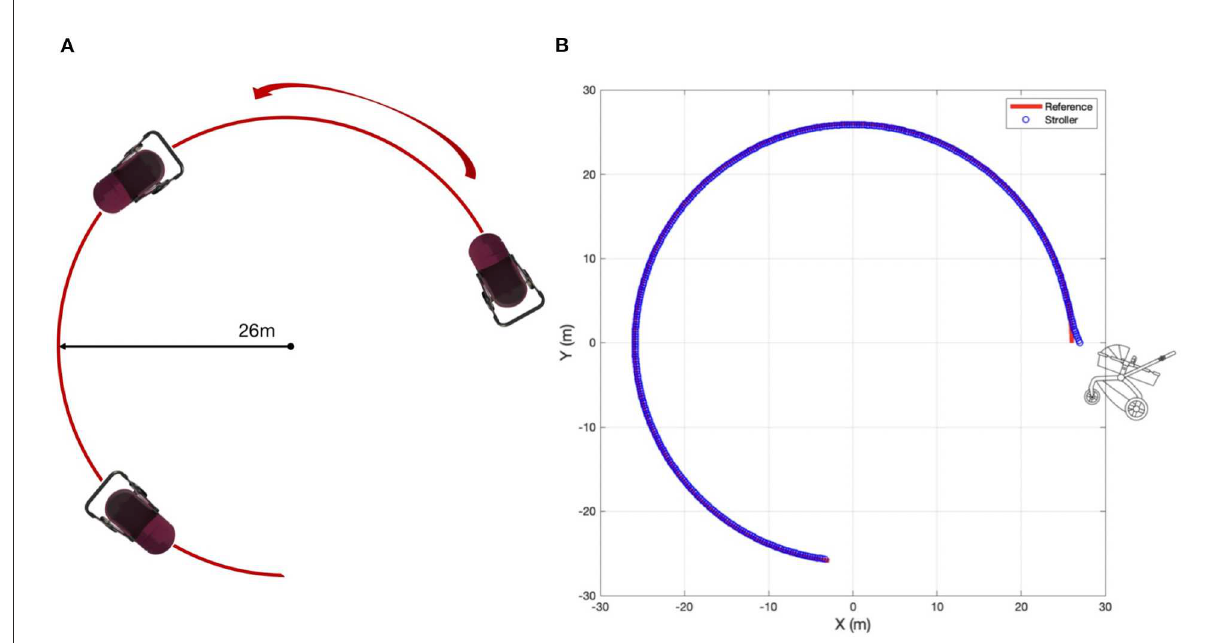
FIGURE11 (A) The illustration of experimental setup for the circle path tracking task for the baby stroller control. (B) Experimental results of following the circle path.